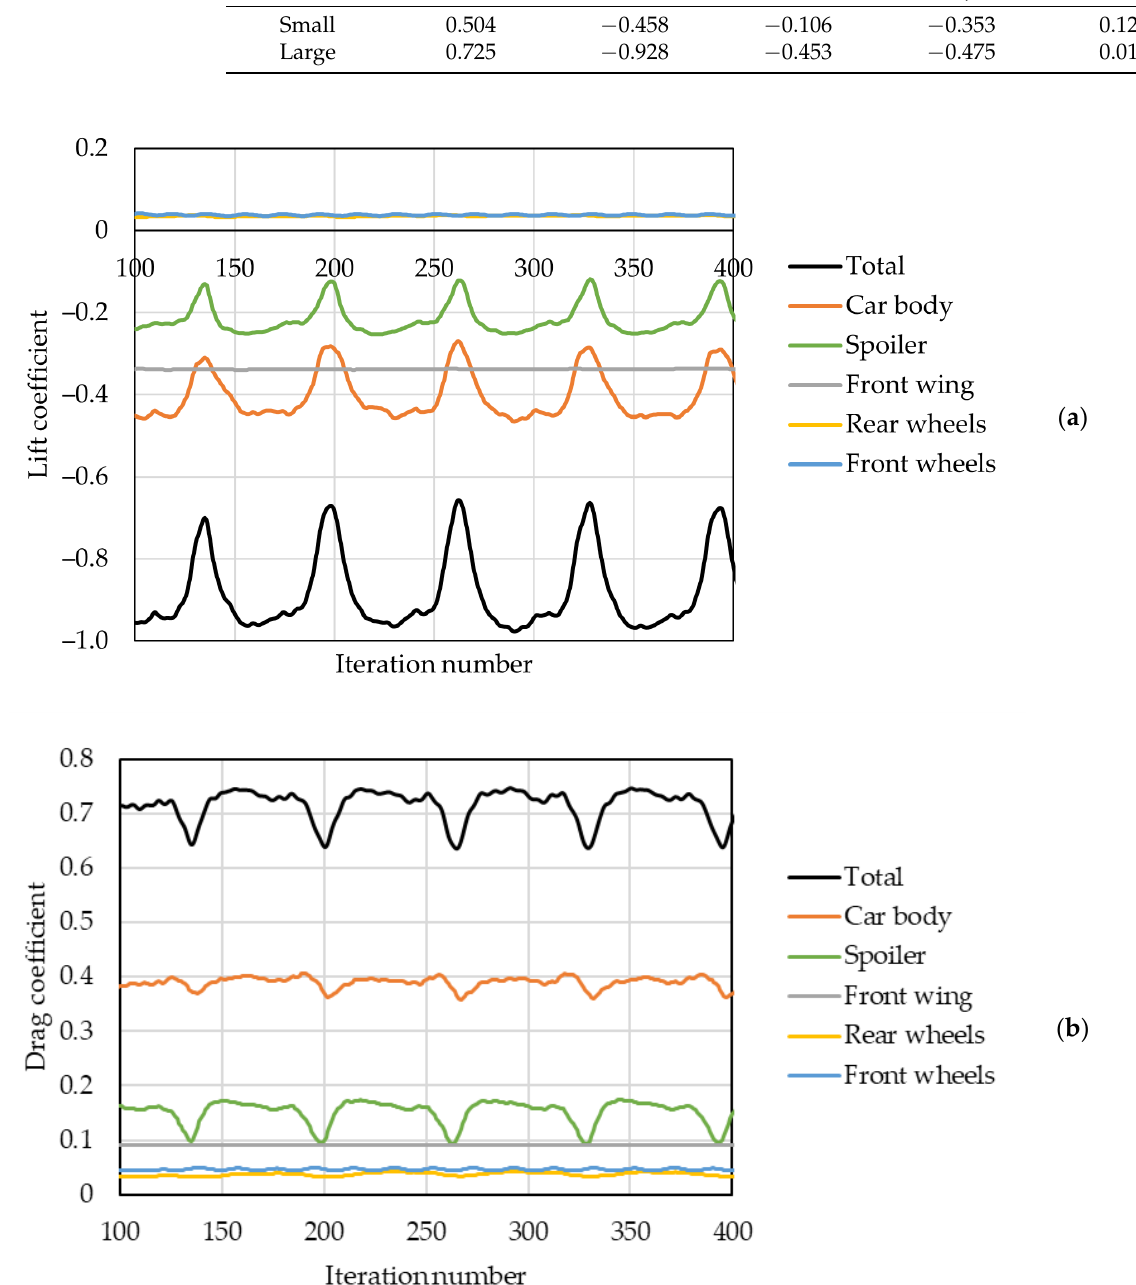
Figure 39. Forces acting on the car body in the case of a larger spoiler: ( a ) drag coefficient as a function of the iteration number; ( b ) lift coefficient as a function of the iteration number.